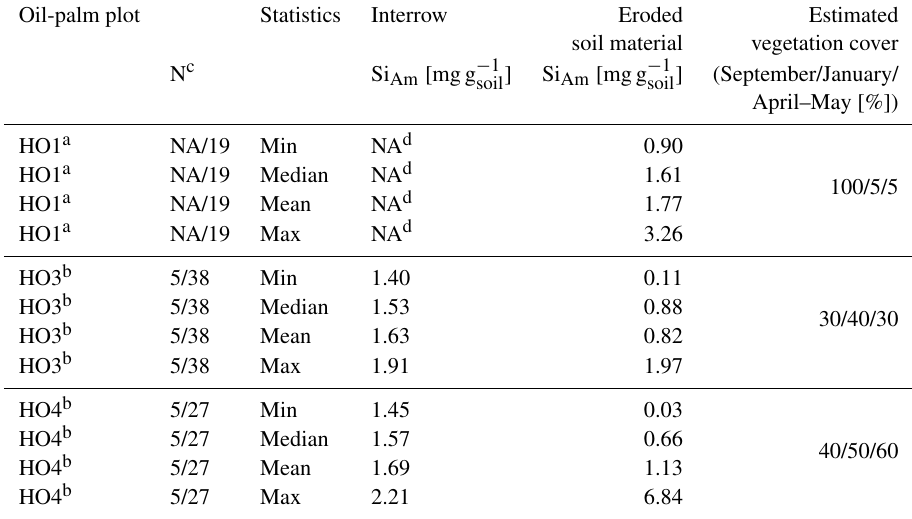
a Si Am concentrations for plot HO1 as of February 2019 (after manual weeding). for the whole sampling duration. c Replicates for interrow topsoil samples/replicates for eroded soil samples. d Every interrow on plot HO1 contained stacked frond piles with no sampling possible. NA: not available.